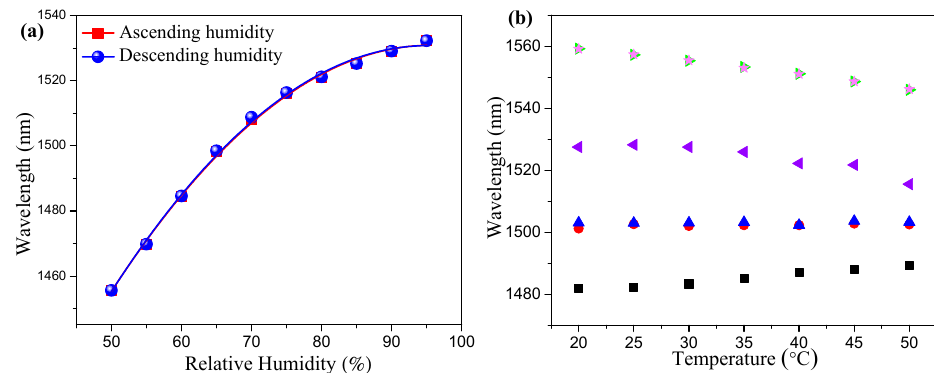
Figure 7. ( a ) The fitting line of the resonance dips under the ascending and descending humidity process. ( b ) Temperature response of the LPFGs without and with polymer coatings at different humidity. ( ► ) 66% RH without PEG/PVA composite film coating, ( ★ ) 70% RH without PEG/PVA composite film coating, ( ■ ) 60% RH with PEG/PVA composite film coating, ( ● ) 66% RH with PEG/PVA composite film coating, ( ▲ ) 70% RH with PEG/PVA composite film coating, ( ◄ ) 90% RH with PEG/PVA composite film coating.